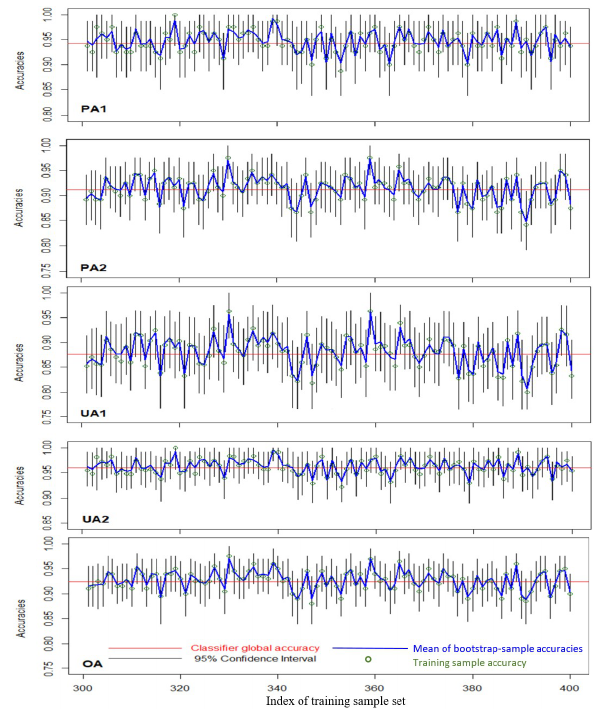
Figure 1. Illustration of 95% bootstrap confidence intervals for the 2-class, 2-feature